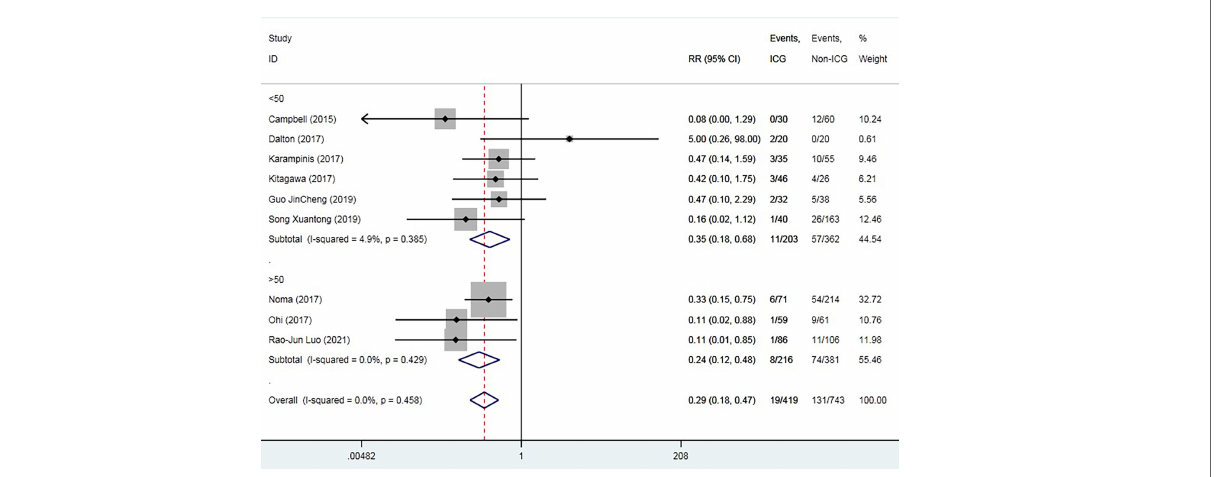
FIGURE 4 | Forest plot for subgroup analysis of anastomotic leak based on experimental group sample size.